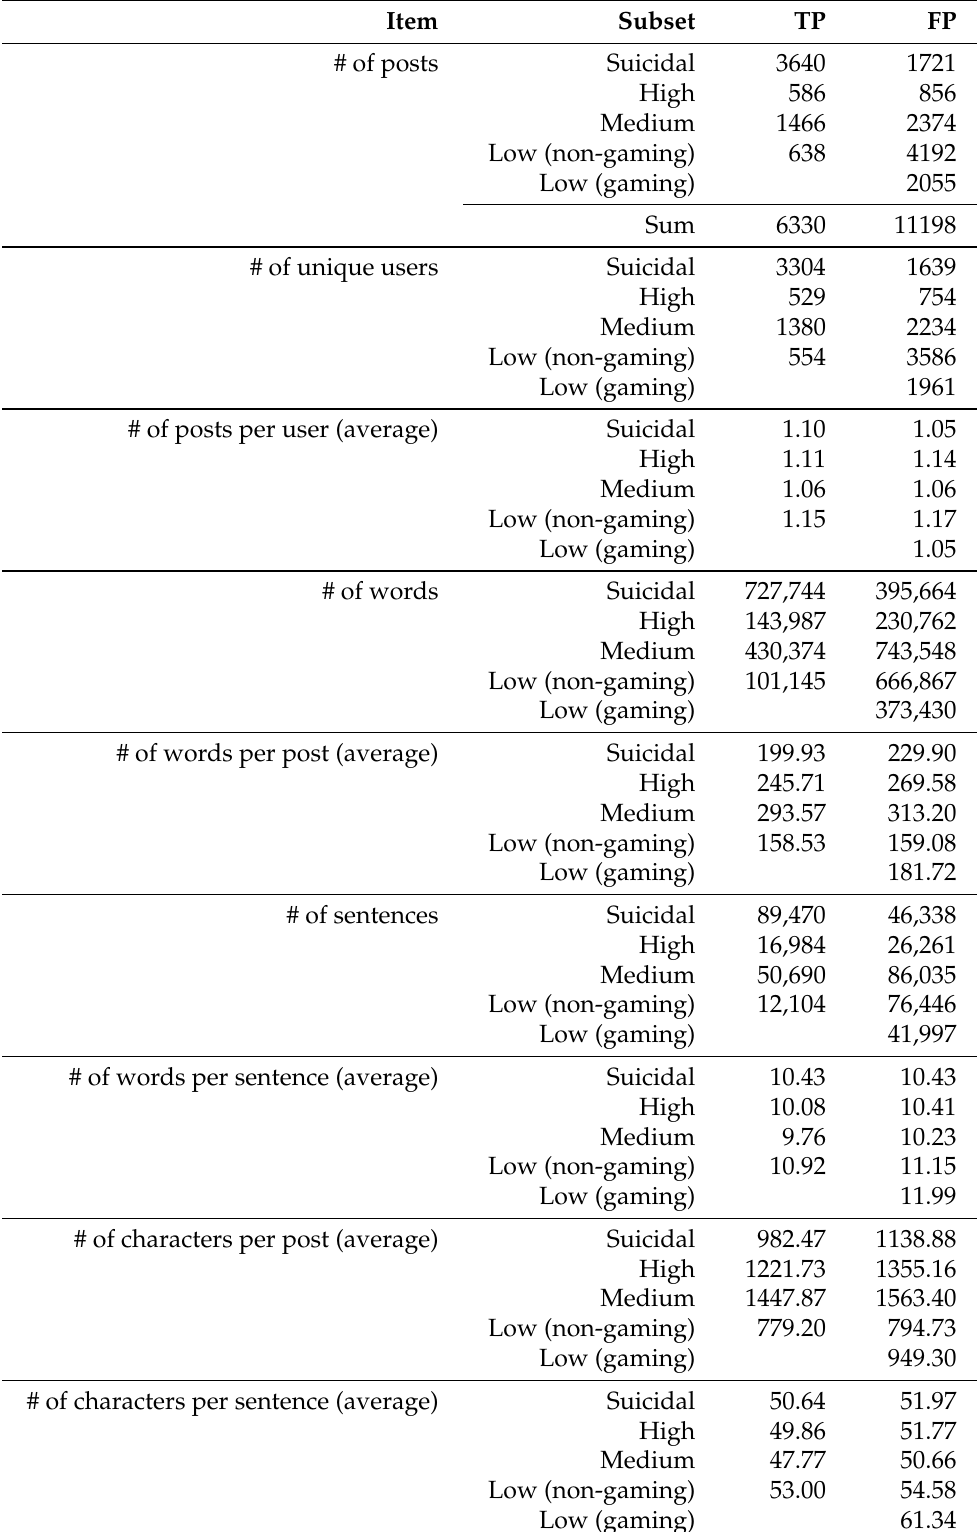
Table 1. Statistics of the data included in the